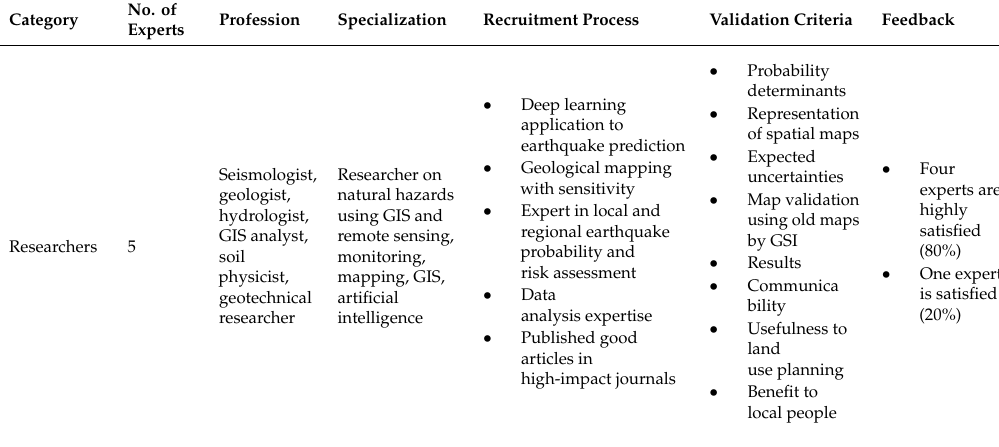
Table 6. Experts’ profile and feedback on the probability